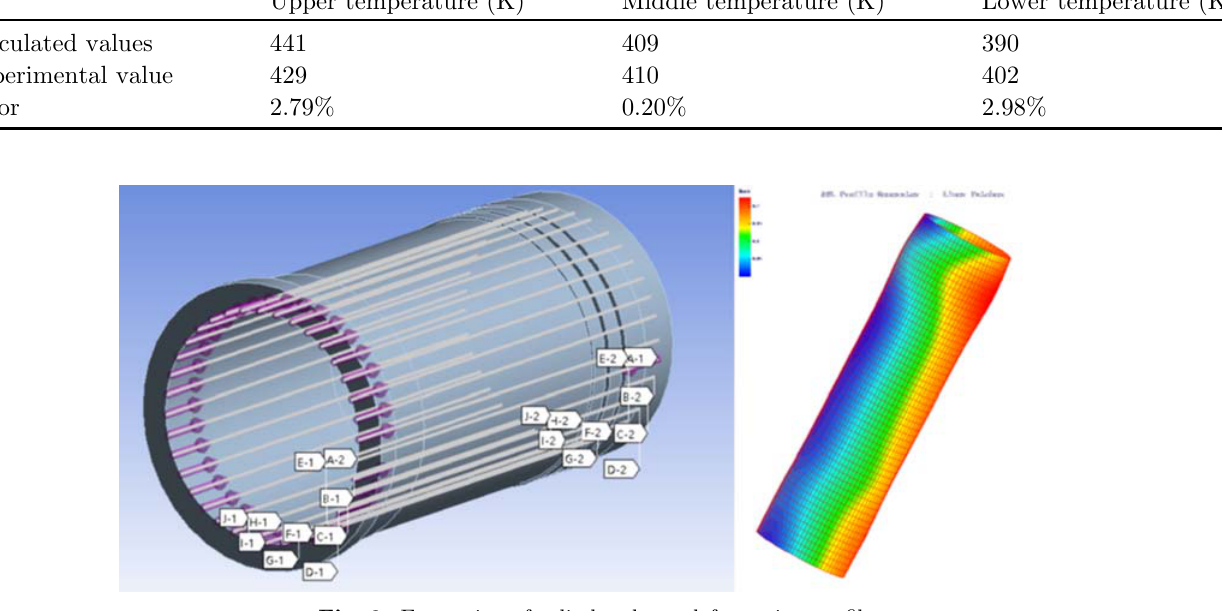
Fig. 9. Extraction of cylinder sleeve deformation pro fi le.